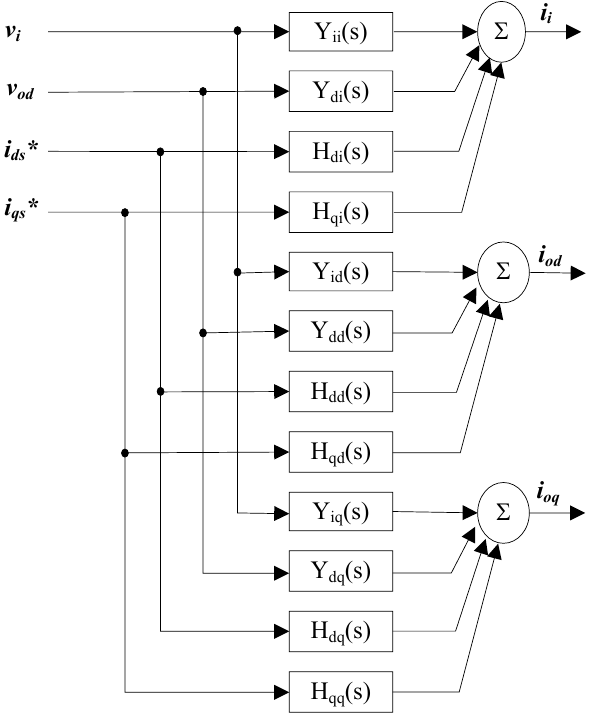
Figure 8. Small-signal blackbox model of the